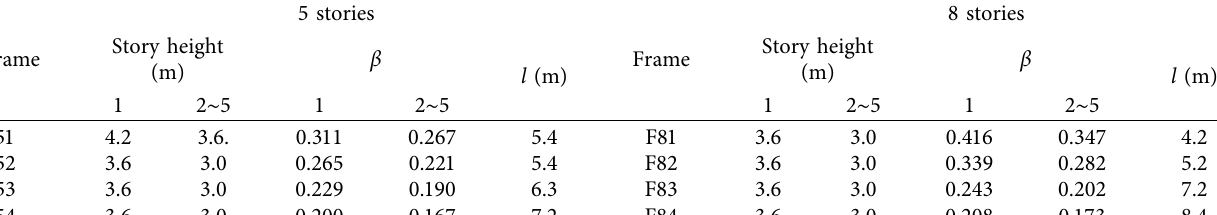
Table 4: Information of structural models with different β .